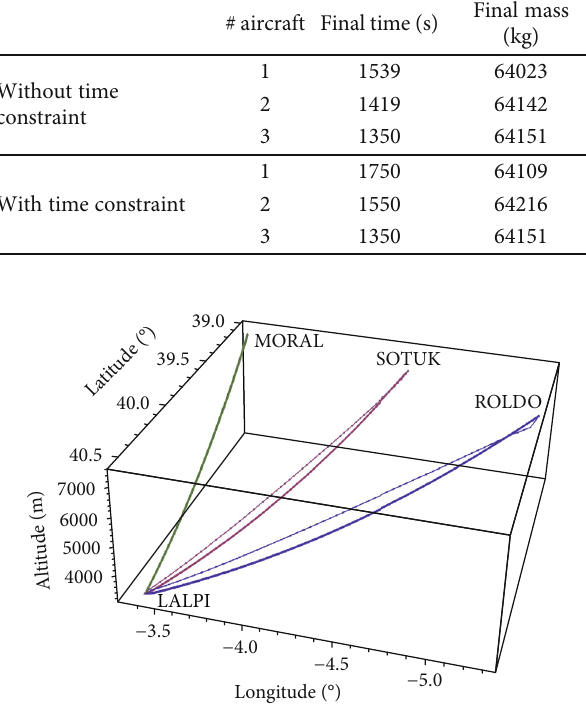
Figure 4: Experiment 1. 3D view of the paths with (thin lines) and without (thick lines) time-based separation constraints.